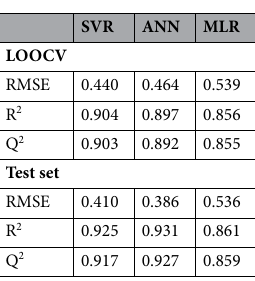
Table 3. RMSE and the squared correlation coefficient (R 2 and Q 2 ) of antioxidant activity prediction in LOOCV and test set of three models (SVR, ANN and MLR).